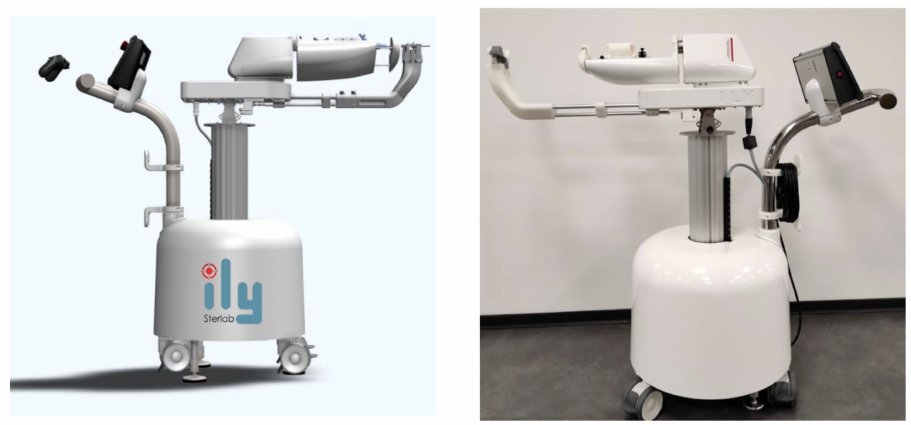
Figure 5. ILY ® robot.